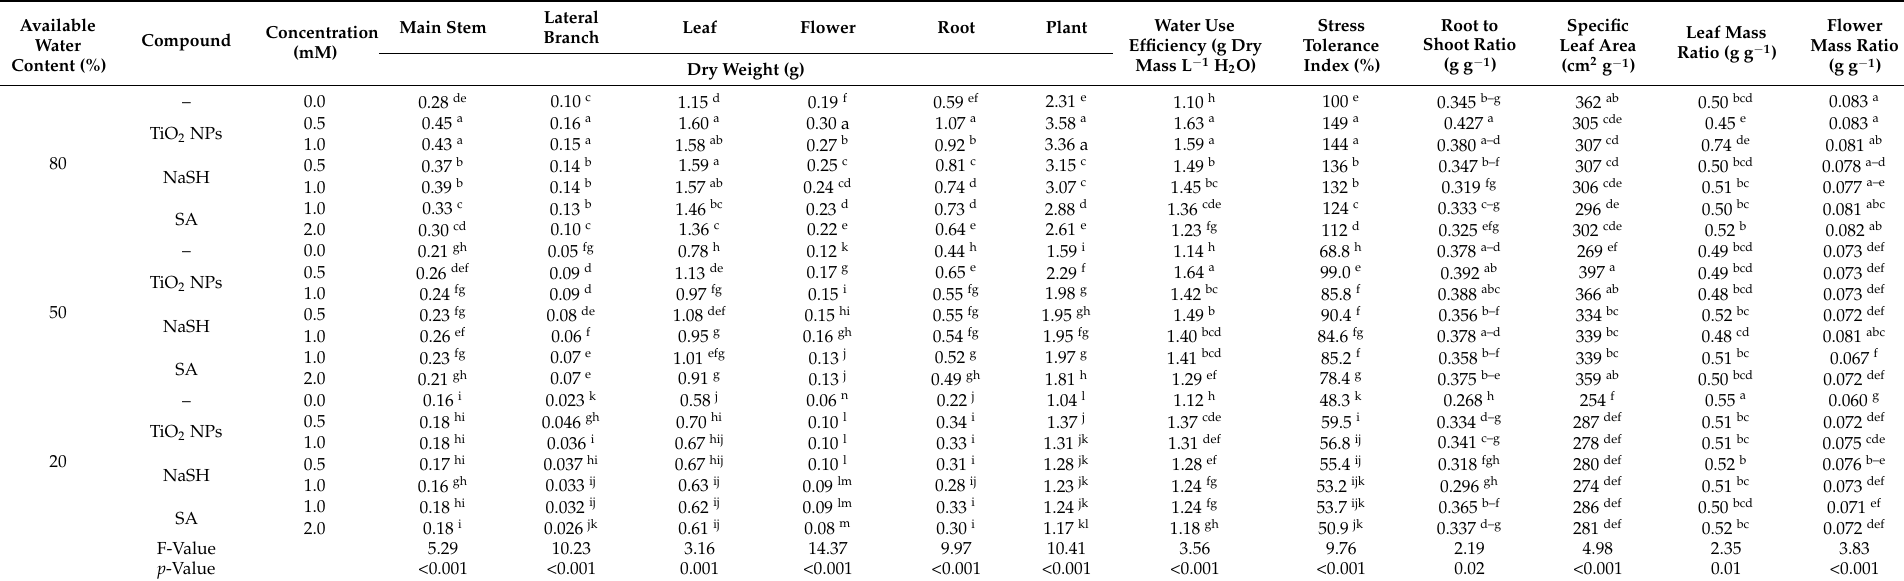
Table 4. Plant growth, biomass allocation and morphology of periwinkle ‘Pacifica XP Really Red’ plants receiving exogenous application of titanium dioxide nanoparticles (TiO 2 NPs; 0, 0.5 and 1 mM), sodium hydrosulfide (NaSH; 0.5 and 1 mM), or salicylic acid (SA; 1 and 2 mM) under different watering levels (80, 50 and 20% available water content) during cultivation. Means followed by different letters indicate significant differences ( p = 0.05; comparison in columns). Values are the mean of four